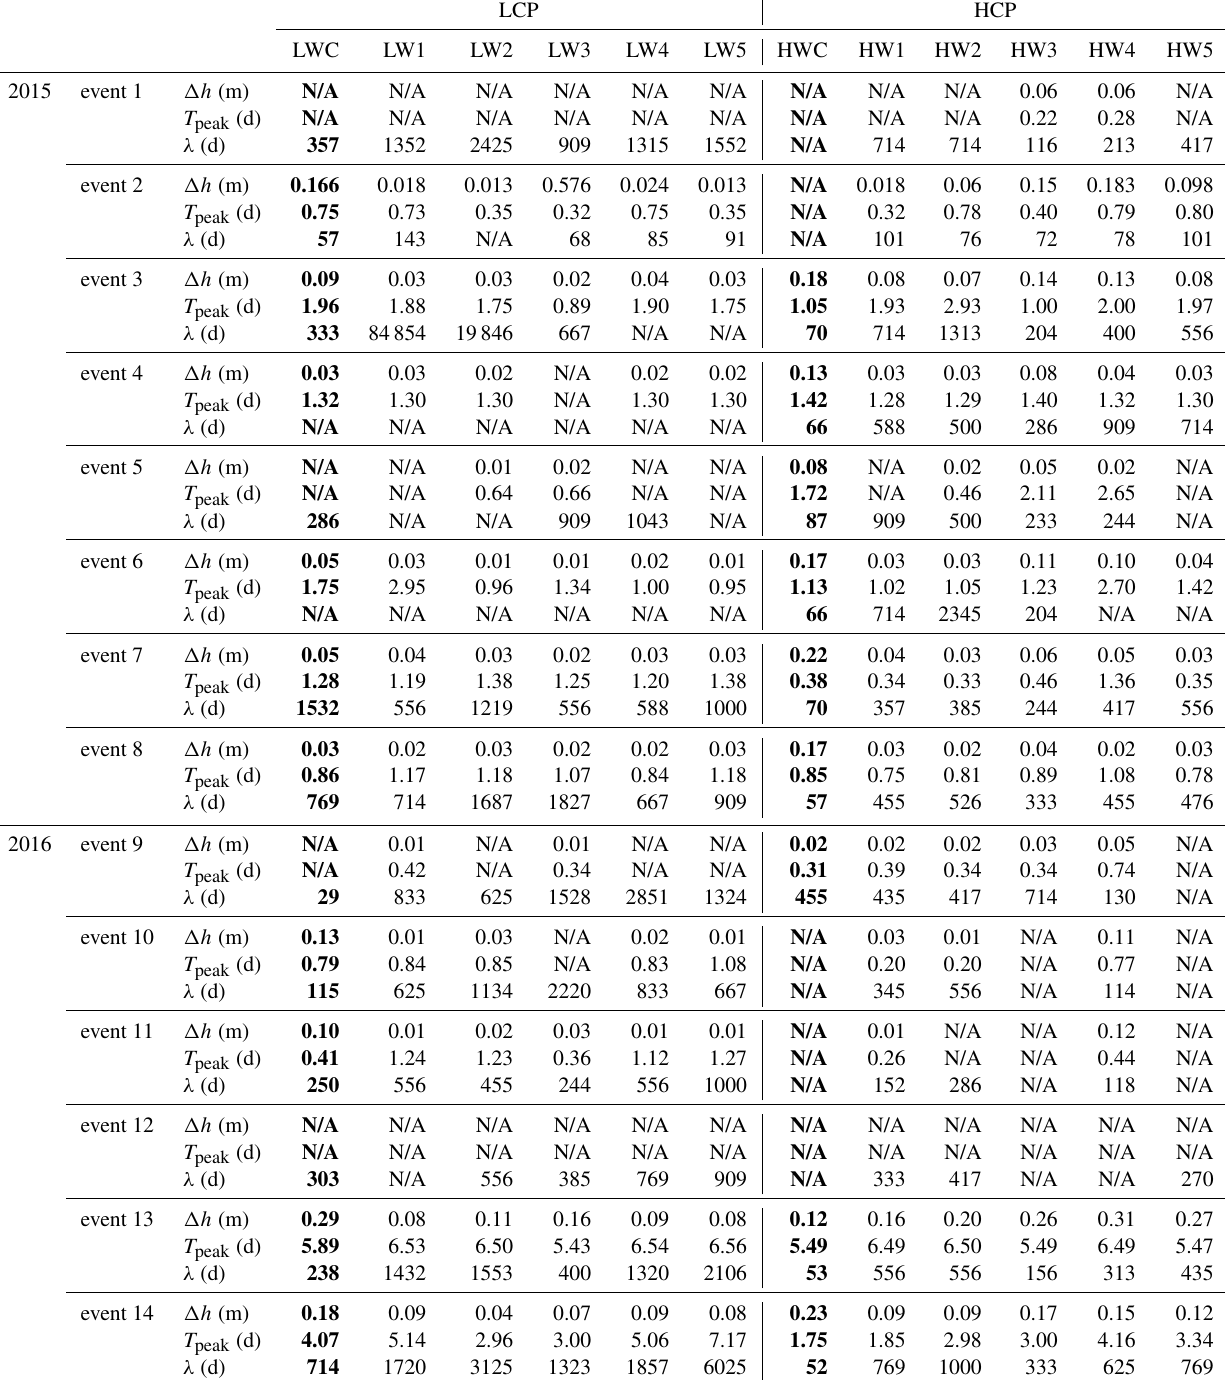
Table 1. Response and recovery data from observation wells. Bold font indicates wells in polygon centers. Change in head (cid:49)h (m), time to peak T peak (d), and characteristic response λ (d). N/A = not available; the data necessary to make this estimate was not